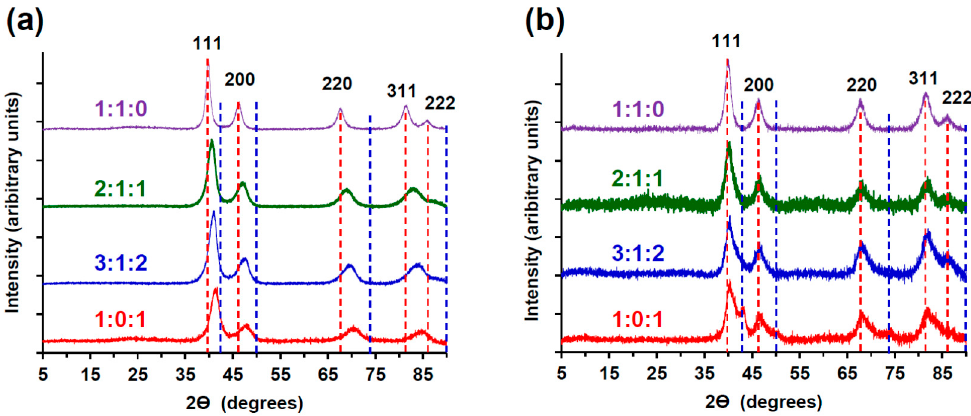
Figure 5. X-ray diffraction spectra of platinum-copper macrotubes-macrobeams reduced with ( a ) DMAB or ( b ) NaBH 4 from Pt 2 − : Pt 2 + :Cu 2 + salt ratios of 1:1:0, 2:1:1, 3:1:2, and 1:0:1. Peaks were indexed to JCPDS reference number 01-087-0640 for platinum (red dashed lines), and 03-065-9026 for copper (blue dashed lines).